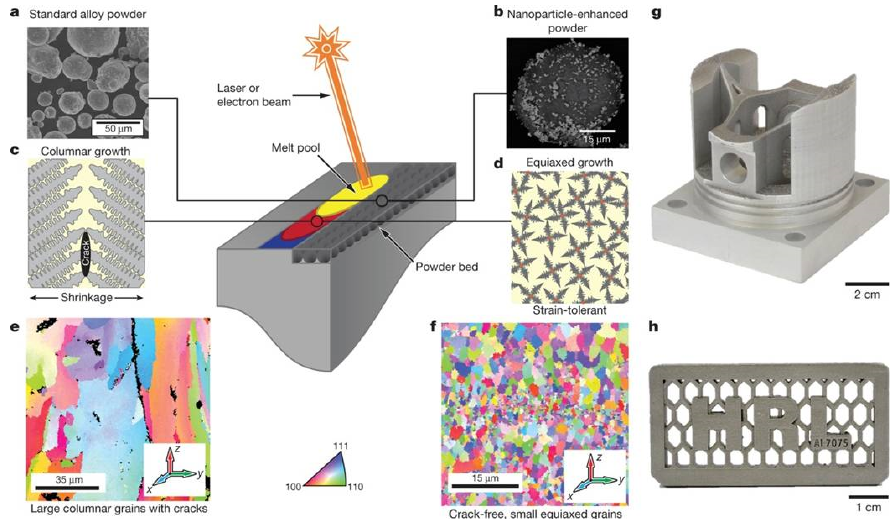
Figure 48. The central schematic presents an overview of the additive manufacturing process, whereby a directed energy source (laser or electron beam) melts a layer of metal powder (yellow), which solidifies (red to blue), fusing it to the previous (underlying) layer of metal (grey). ( a ) Conventional Al7075 powder feedstock. ( b ) Al7075 powder functionalized with nanoparticles. ( c ) Many alloys including Al7075 tend to solidify by columnar growth of dendrites, resulting in cracks due to solidification